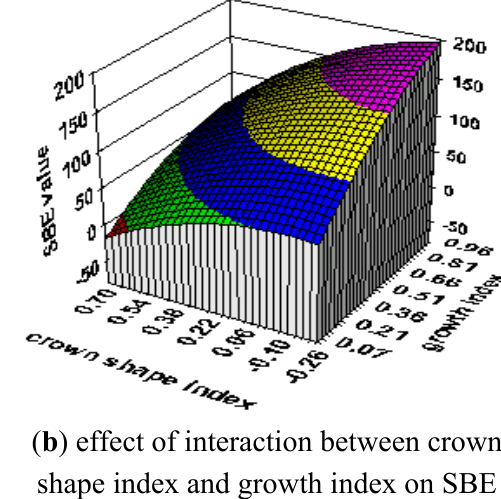
Figure 2. Effect of interaction between different indices on